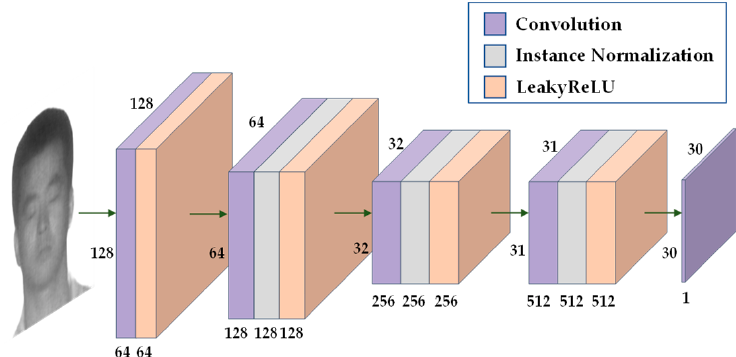
Figure 5. The architecture of the discriminator in the CycleGAN .